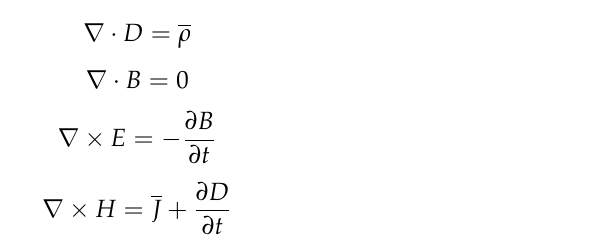
Figure 5. V ds -dependent input, output, and reverse transfer capacitances.